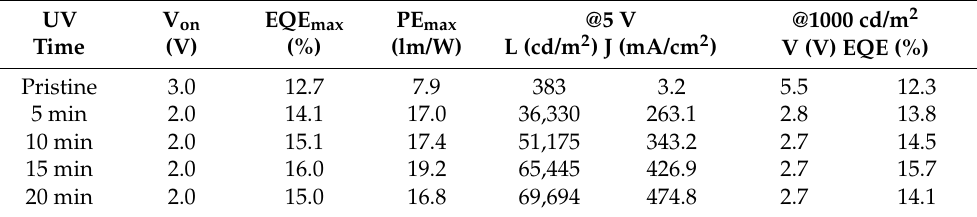
Table 1. The characteristics of the QLEDs with different UV irradiation